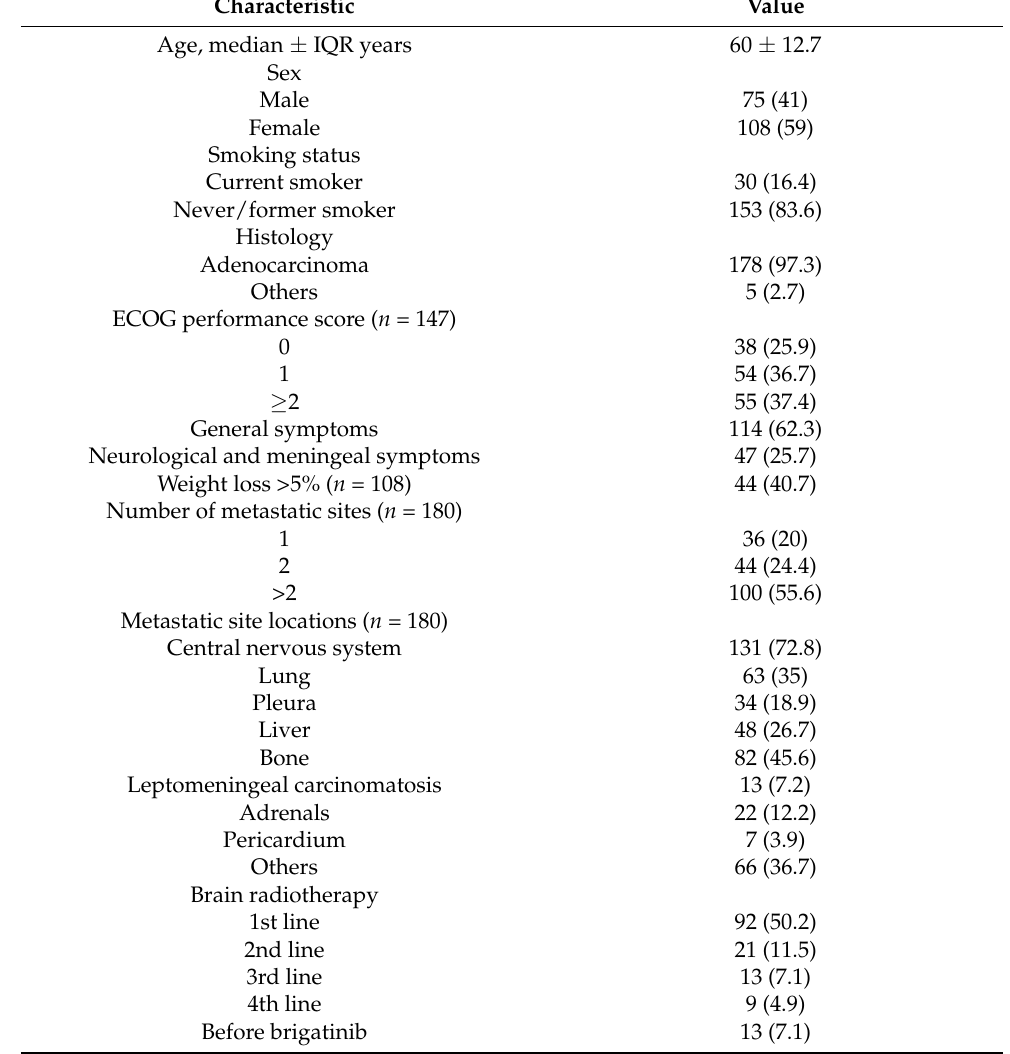
Table 1. Characteristics of the 183 patients with ALK + advanced NSCLCs before brigatinib. Characteristic